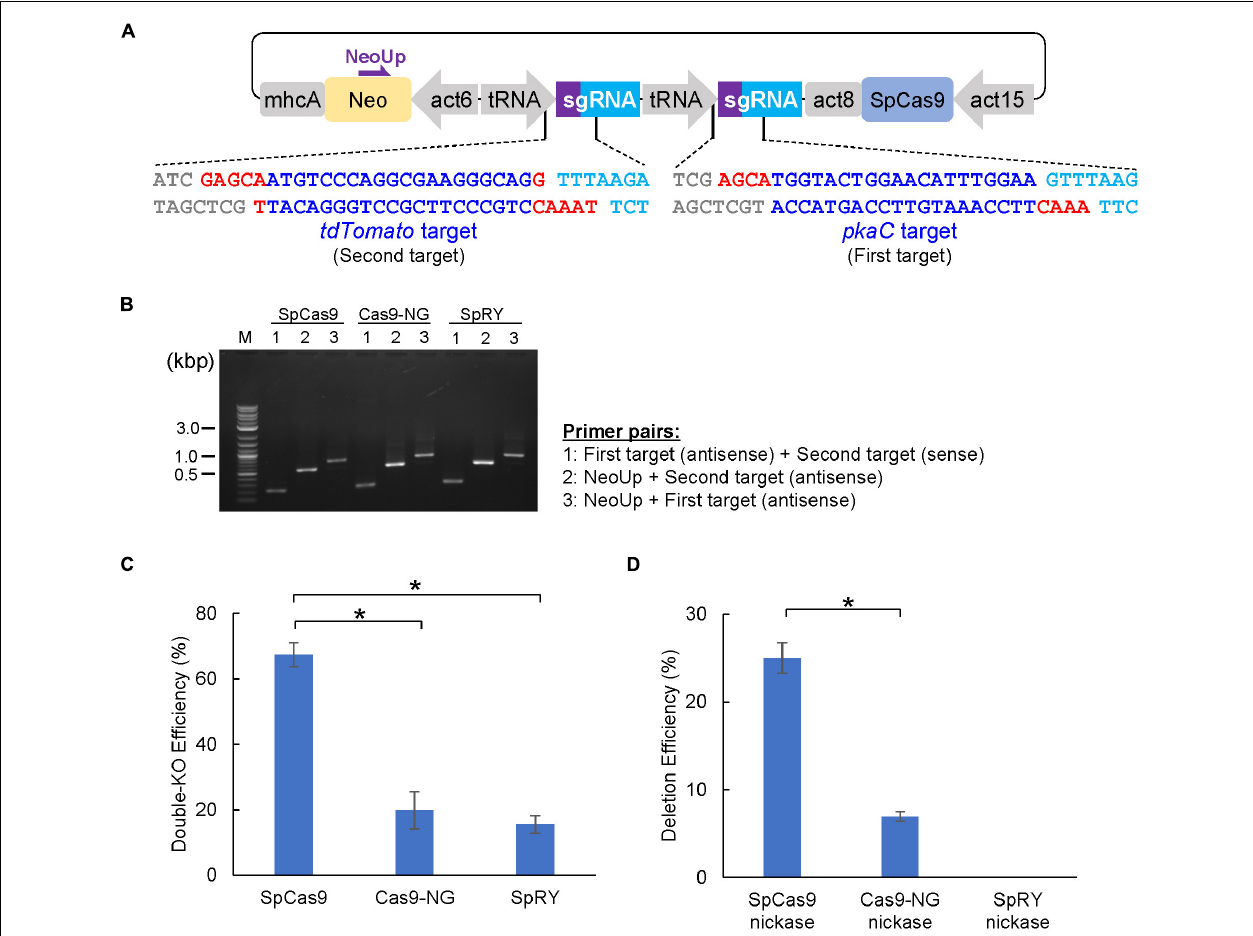
FIGURE 4 | CRISPR/Cas9-mediated double-knockout and genomic deletion. (A) Schematic of the dual sgRNA expression vector designed for single cloning step. Red and blue letters represent overhands for the cloning and 20-nt of target sequences, respectively. (B) Correct insertion of the first and second targets was confirmed via colony PCR. (C) Summary of double knock-out efficiencies by various Cas9 and sgRNA that target pkaC and tdTomato gene. (D) Summary of deletion efficiency in pkaC gene by various Cas9 nickase. Data shown are mean ± SEM ( n = 3 biological replication). * P <